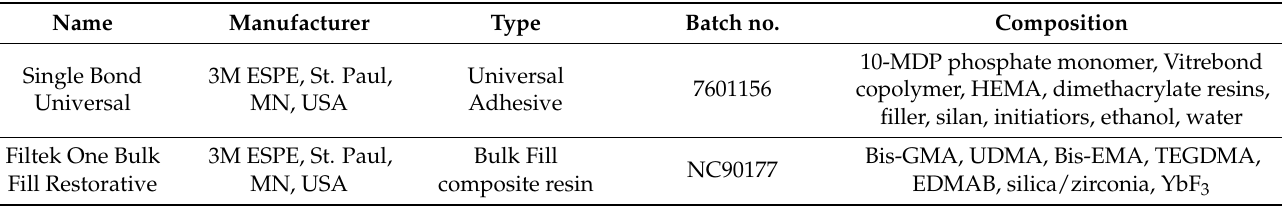
Table 1. Composition of the materials.